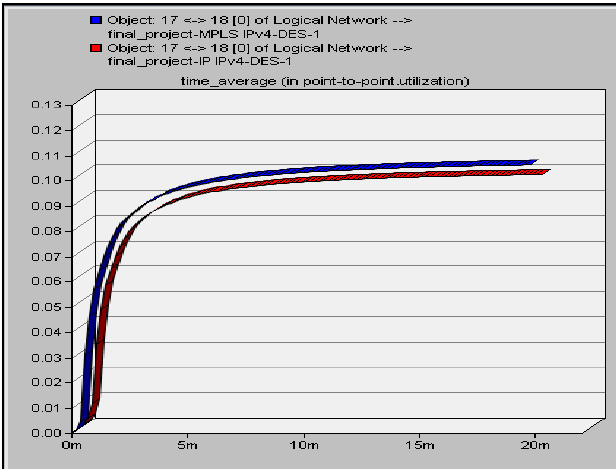
Link Utilization Comparison of IPv4 and MPLS IPv4 along 17 to 18